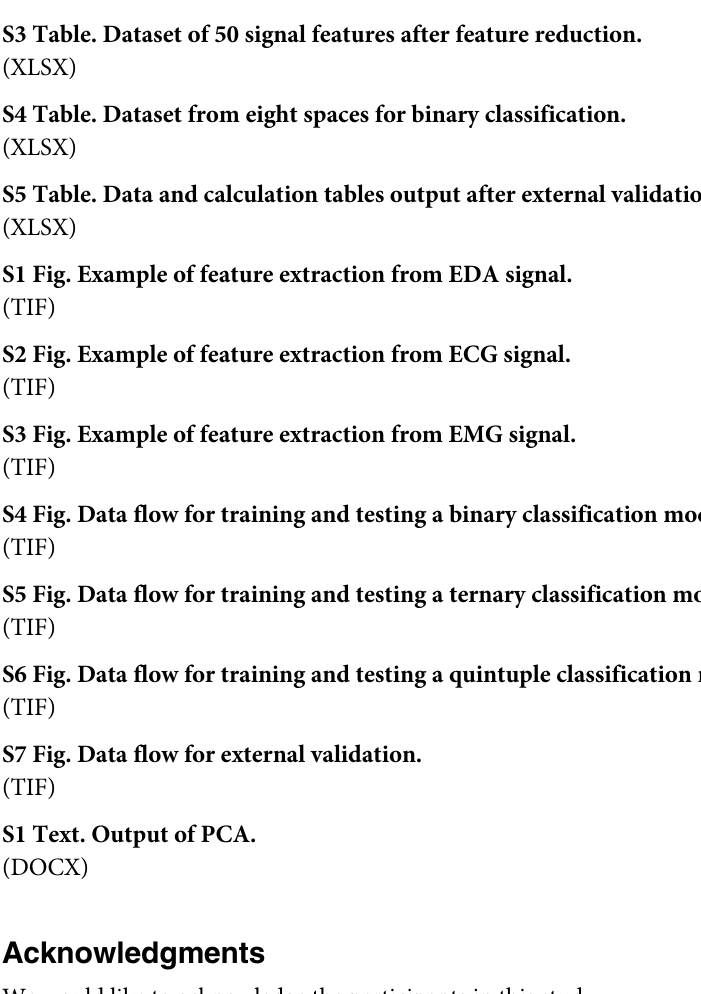
S1 Table. Valence statistics of participants in 10 public spaces. S2 Table. Dataset of 68 signal features extracted from EDA, EMG and ECG signals. (XLSX) S3 Table. Dataset of 50 signal features after feature reduction. S4 Table. Dataset from eight spaces for binary classification. S5 Table. Data and calculation tables output after external validation. S1 Fig. Example of feature extraction from EDA signal. S2 Fig. Example of feature extraction from ECG signal. S3 Fig. Example of feature extraction from EMG signal. S4 Fig. Data flow for training and testing a binary classification model. S5 Fig. Data flow for training and testing a ternary classification model. S6 Fig. Data flow for training and testing a quintuple classification model. S7 Fig. Data flow for external validation. S1 Text. Output of